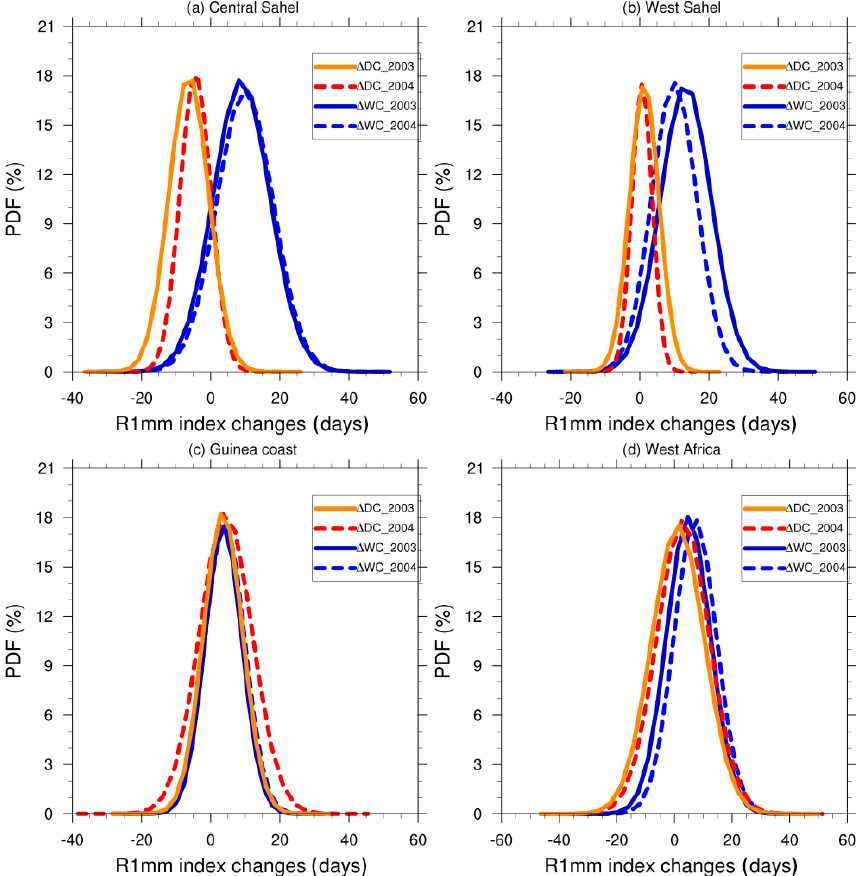
Figure 3. PDF distributions (%) of mean values of the changes in the number of the wet days in JJAS 2003 and JJAS 2004 over the (a) Central Sahel, (b) West Sahel, (c) Guinea coast and (d) West Africa domains derived from dry ( (cid:49) DC) and wet ( (cid:49) WC) experiments with respect to the control experiment. Table 3. Summary of the maximum values of change in PDFs for the R1mm, SDII, CDD, CWD, RX1day and R95pTOT indices. Values in bold indicate regions with the largest changes in maximum values for the dry and wet